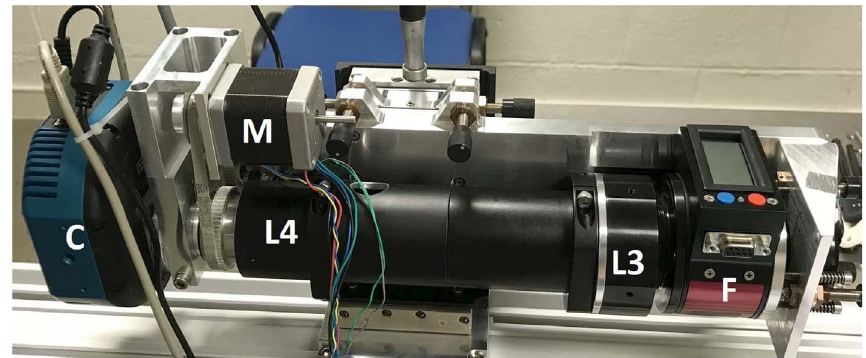
Fig. 2. The chamber of MeteoSpace H a telescopes. L3 = chamber objective; F = DayStar Quantum PE Fabry Pérot fi lter; L4 = fi eld corrector/focuser; M = focuser motor; C = cooled CCD camera